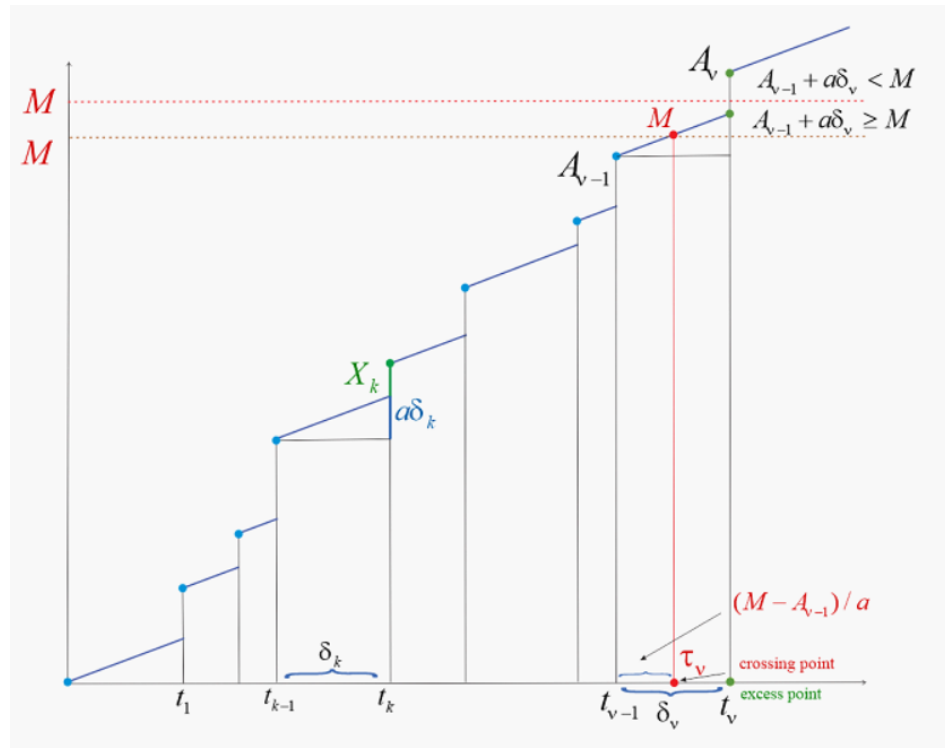
Figure 1. The linear degradation process with